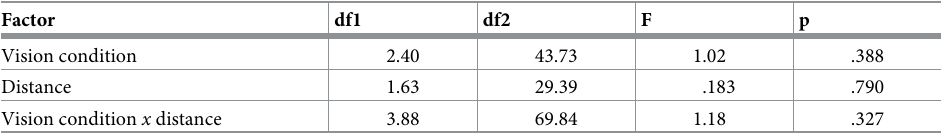
Table 20. Results of the two-factor ANOVA with repeated measures (3 distances; 4 vision conditions) for the response time. Corrected by Greenhouse-Geisser � .